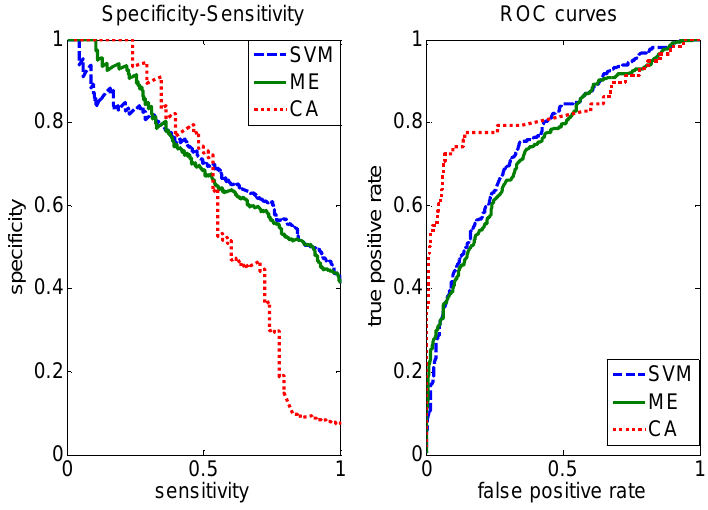
Figure 4. Specificity-sensitivity and ROC curves on the Trim data based on SVM, ME and CA.